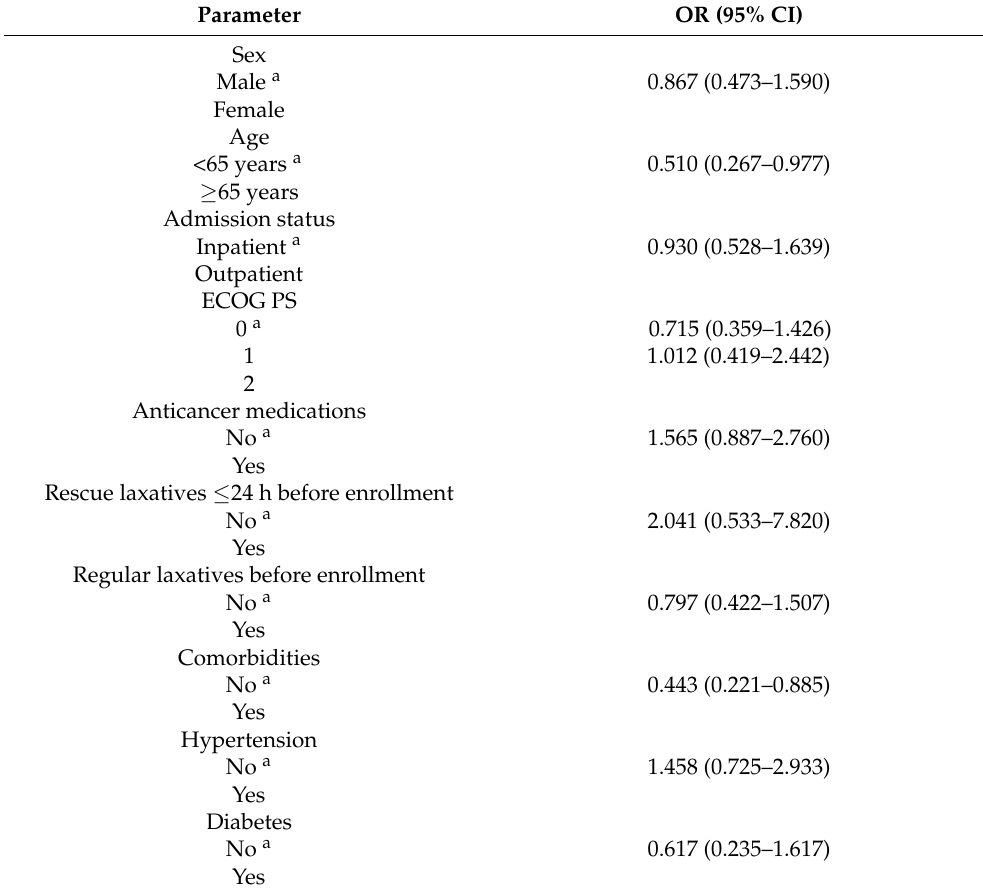
Table 2. Correlation Between OIC and Patient Demographics, Adjusted for BMs in the Past Week (FAS 1